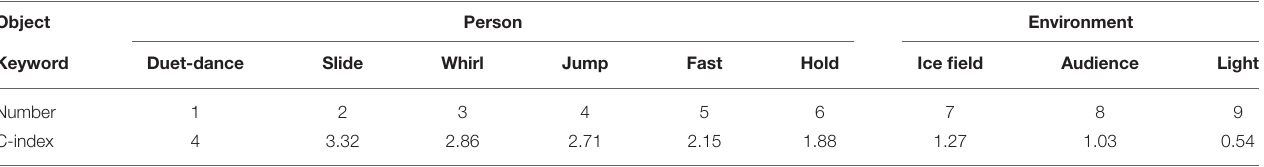
Table 1 . The purpose of the detection is to determine whether the labeling of the sorting number is accurate. Otherwise, the sorting number labeling of the main body and the sub-body will be reassigned. If multiple sub-ontologies and more keywords are determined from the demand information, the ranking numbers are marked sequentially. Table 1 is used to find dance clips from the action